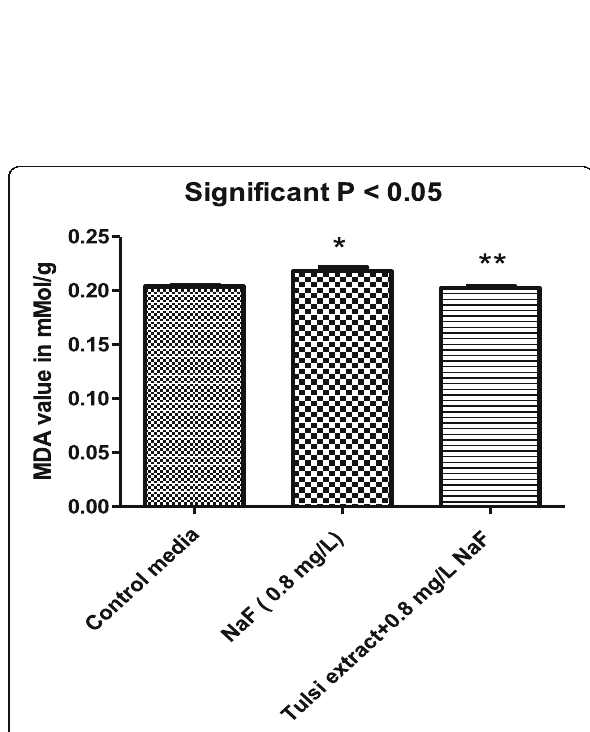
Fig. 7 Lipid peroxidation (MDA) measured in D. melanogaster cultured in different media. *, significant difference between MDA values of flies cultured in Control vs media with NaF; **, significant difference between MDA values of flies cultured in media with NaF vs media with tulsi extract+0.8 mg/L